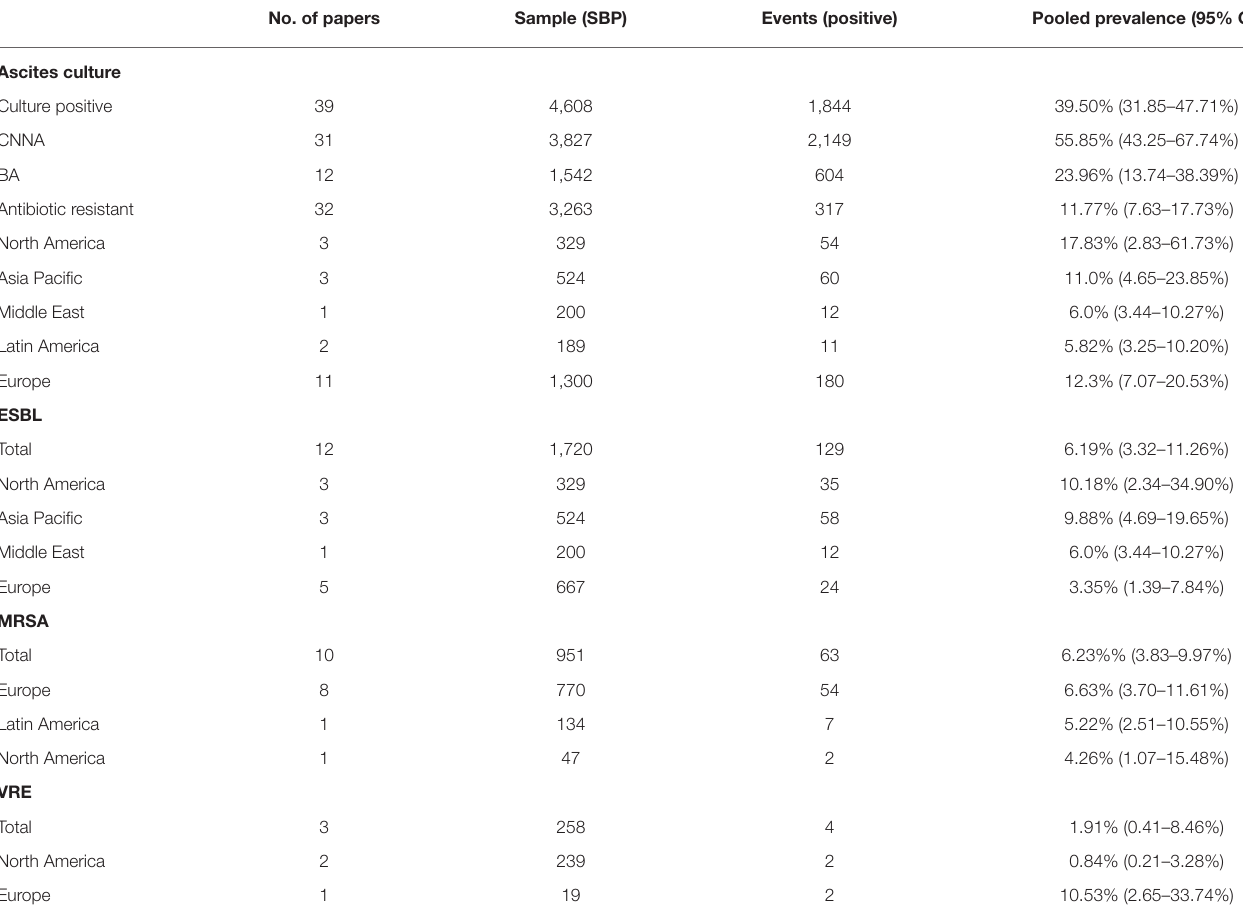
TABLE 3 | Ascitic culture and antibiotic resistance in